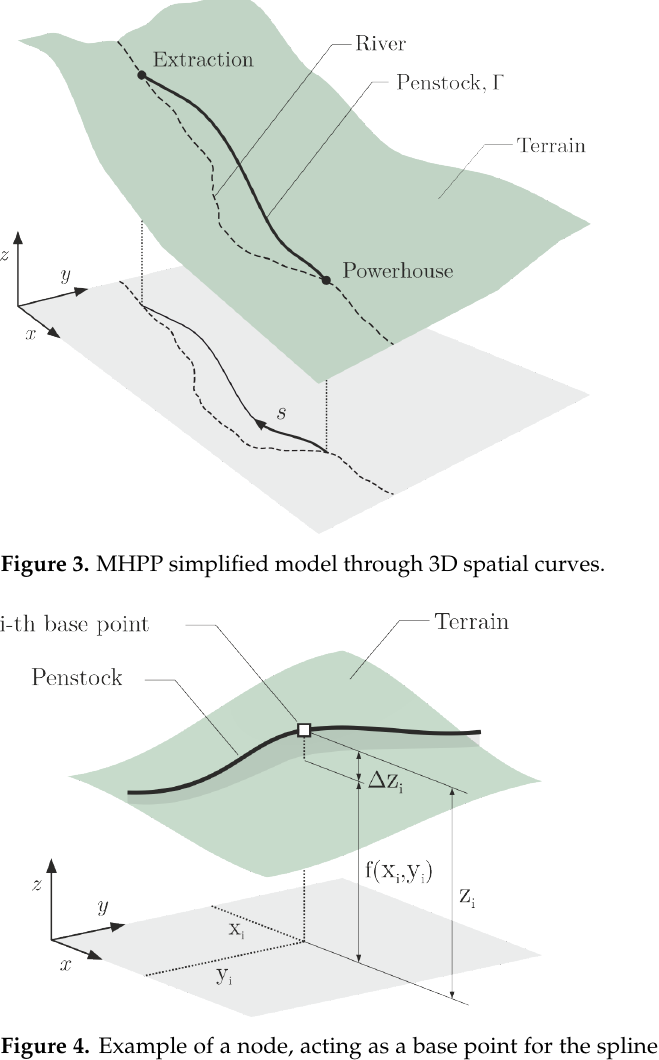
Figure 4. Example of a node, acting as a base point for the spline interpolation. The height of the candidate solutions at the nodes are denoted as z i , in its difference with the height of the terrain at